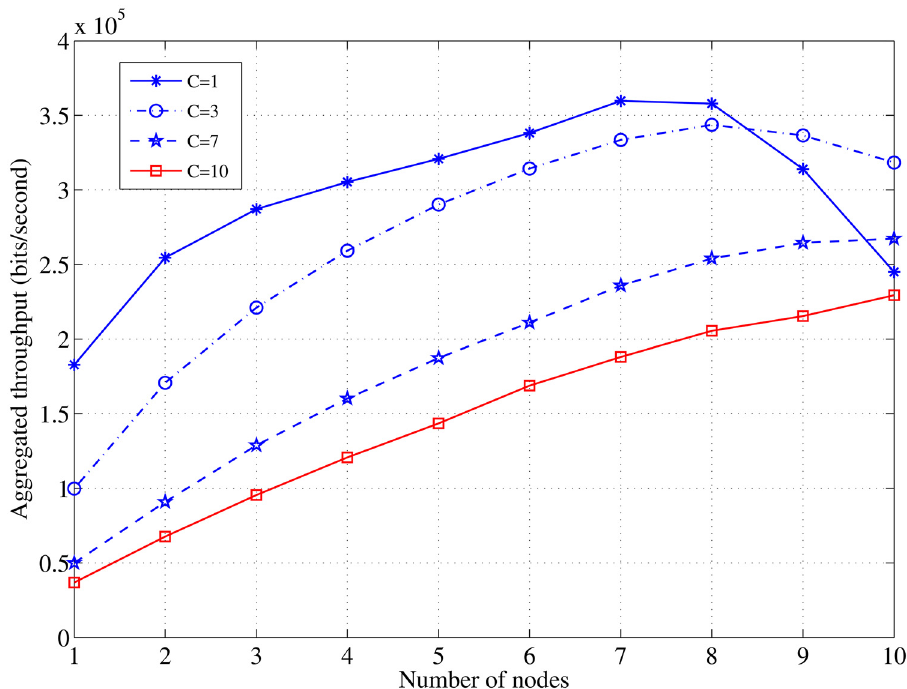
Fig 8. Relationship between N and aggregated throughput in case of various values of C ; τ off = 0.5, L = 1000 [bits].